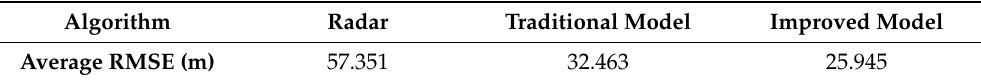
Figure 6. Comparison of fusion models. Table 1. Comparison of average data for fusion models.